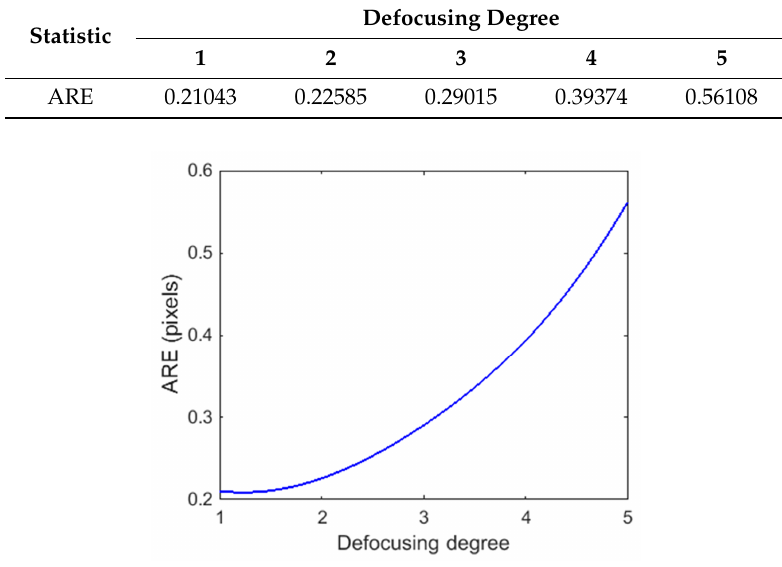
Figure 7. The ARE of a projector under different defocusing degrees.